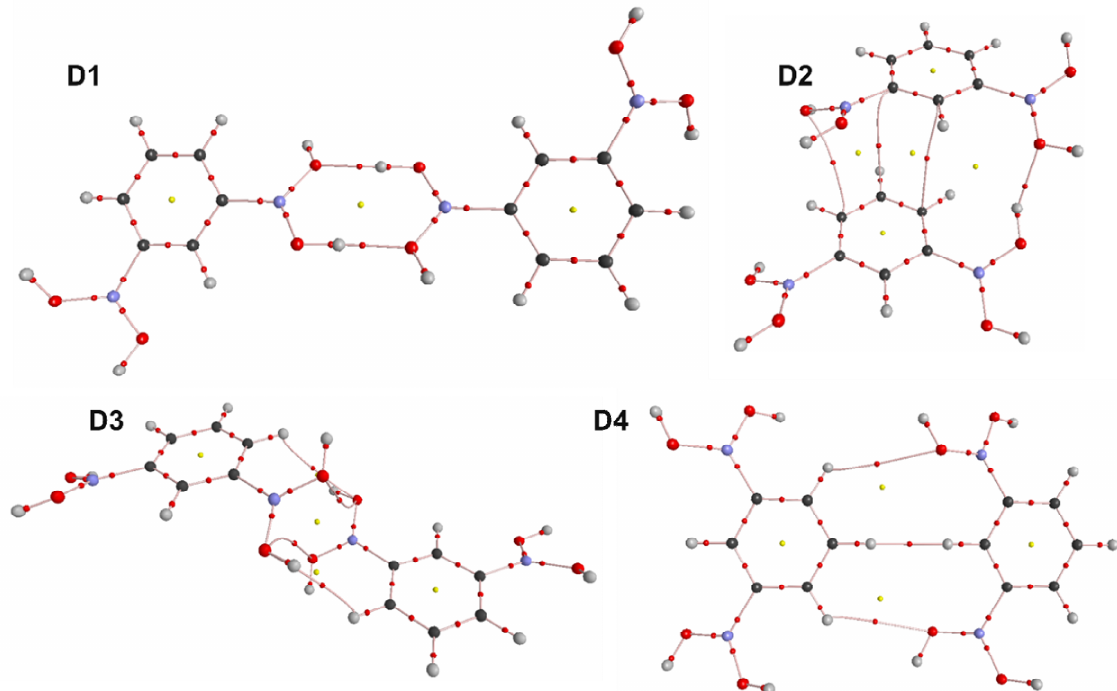
Figure 9. Molecular graph showing the formation O–H . . . O and C–H . . . O interactions within dimeric motifs D1–D4 together with the disposition of critical points of electron density (Bond Critical Point (3, − 1)—red, Ring Critical Point (3, +1)—bright yellow).